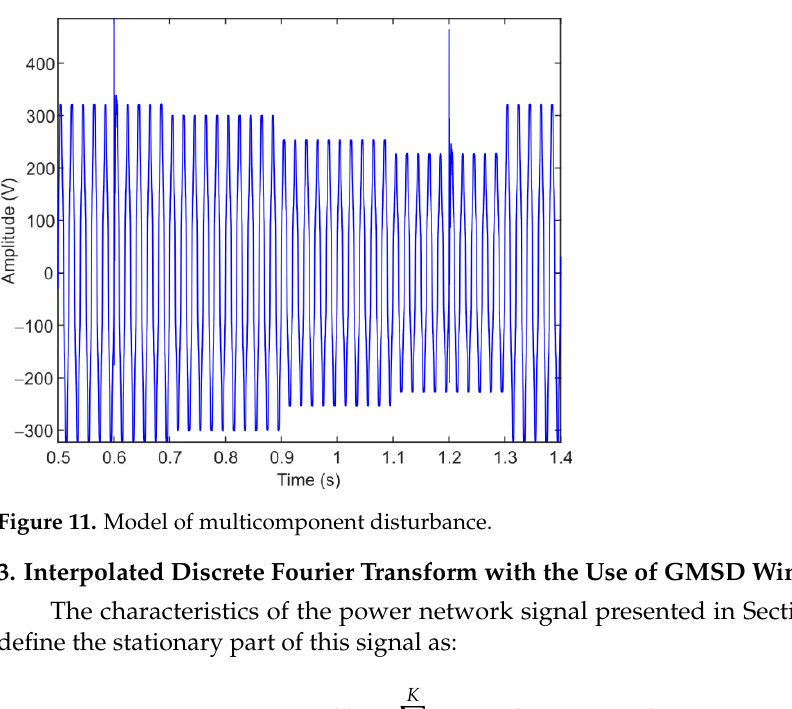
12 of 26 Table 5. Multicomponent disturbance parameters. Type of Disturbance